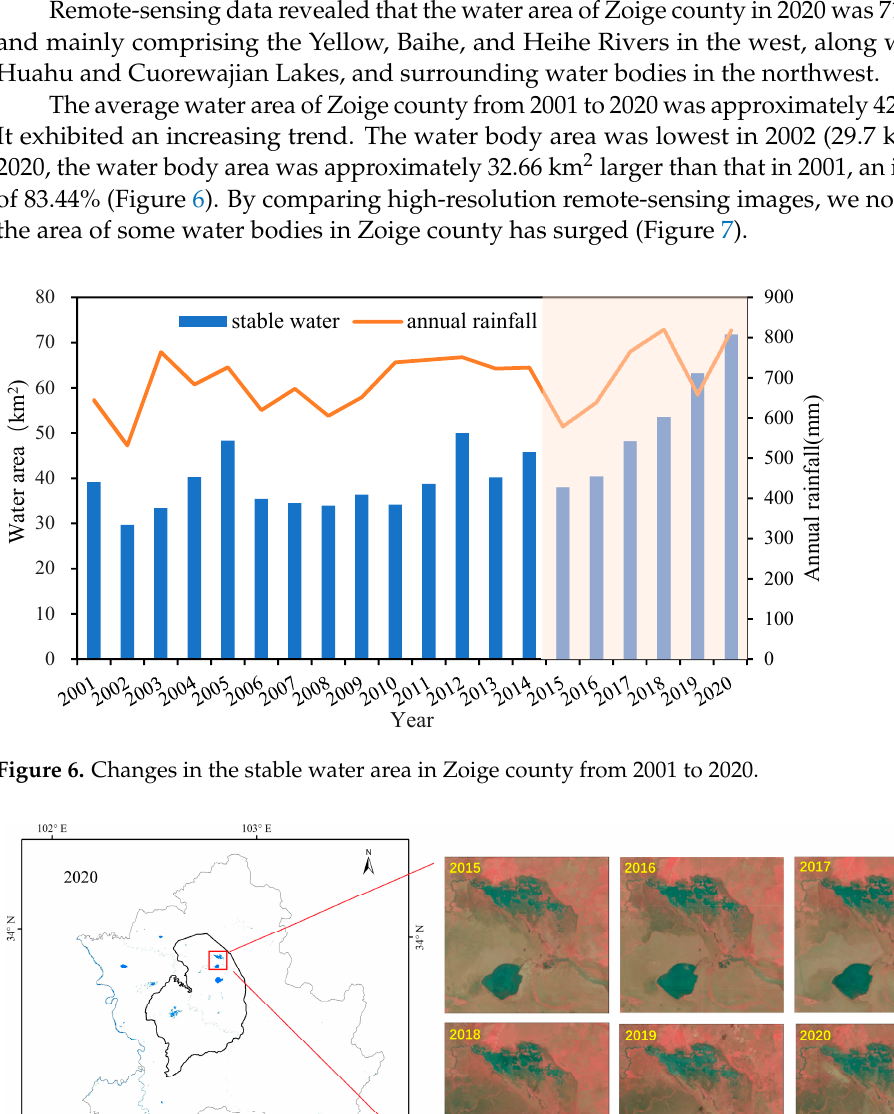
Figure 5. Comparison of remote-sensing images of demolition points of typical illegal facilities